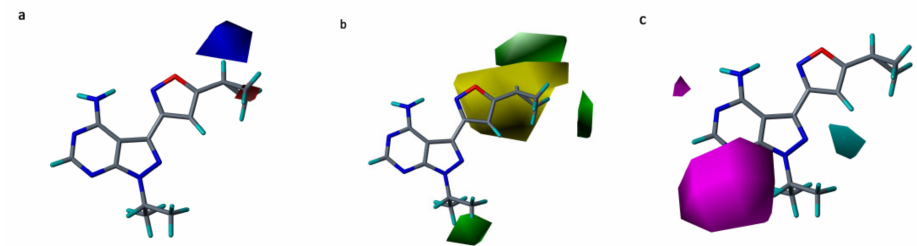
Figure 8. Contour maps for the selected CoMSIA model. ( a ) Electrostatic contour map; ( b ) hydropho- bic contour map; ( c ) hydrogen bond acceptor contour map. Blue contour favors electropositive substitutions, while red contour favors electronegative substitutions; green contour shows the re- gions favorable for hydrophobic substitutions and yellow contours shows the unfavorable regions for bulky substitutions. The favorable region of hydrogen bond acceptor contour map is depicted by magenta color, whereas cyan color denotes that